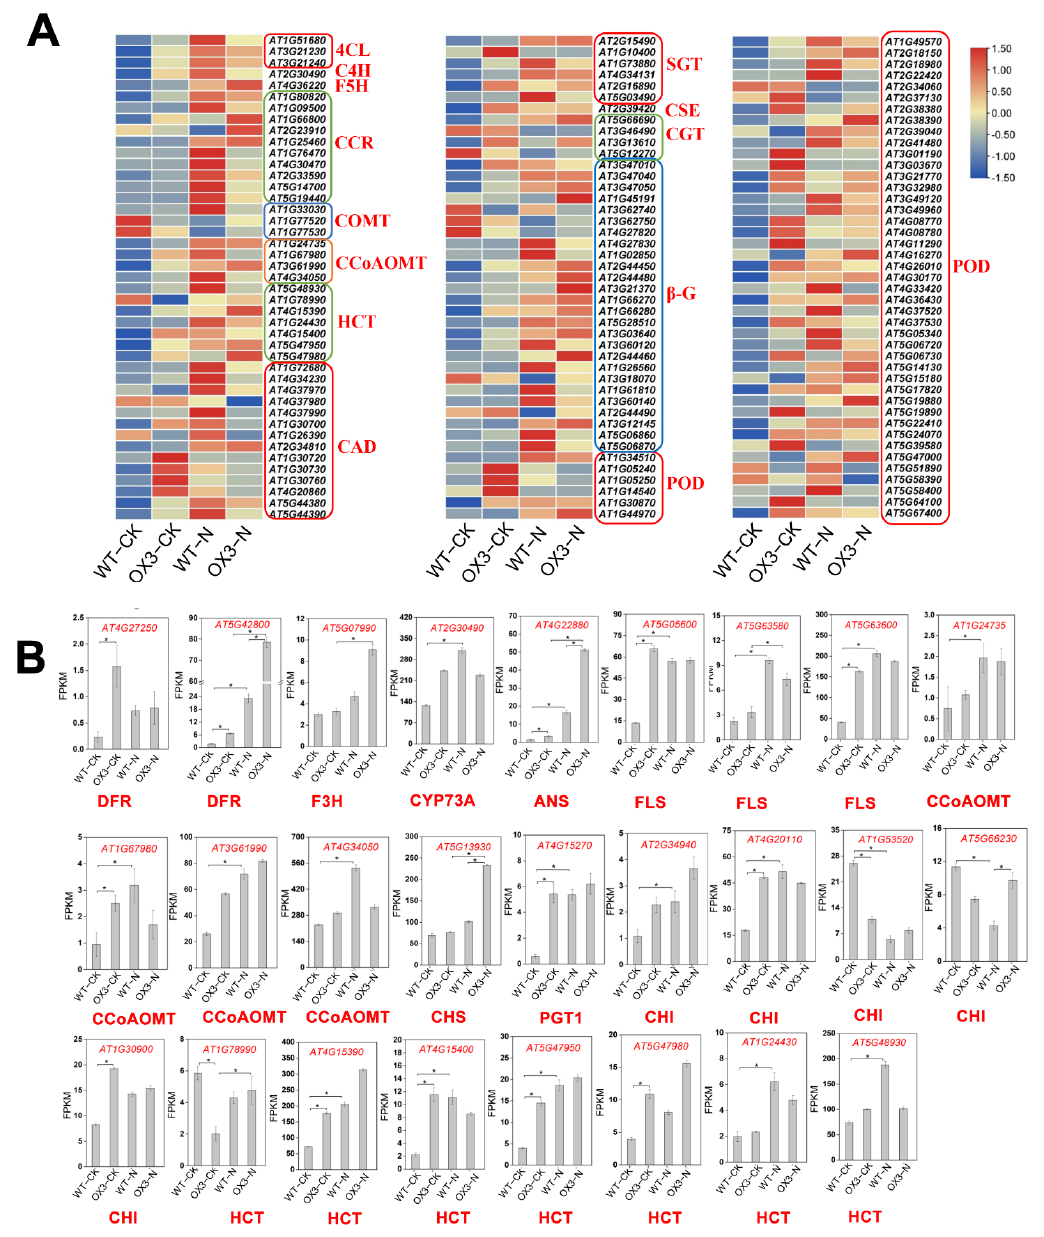
Figure 7. Transcript abundance changes of the phenylpropanoid and flavonoid biosynthesis pathway-related DEGs in Arabidopsis wild type (WT) and transgenic plant (OX3) under NaCl treatment. ( A ) Heat map of DEGs in phenylpropanoid biosynthesis pathway. The log2-transformed FPKM values of DEGs were used to generate the diagram. 4CL, 4-coumarate-CoA ligase; C4H, cinnamate-4-hydroxylase; F5H, ferulate-5-hydroxylase; CCR, cinnamoyl-CoA reductase; CCoAOMT, caffeoyl- CoA O-methyltransferase; COMT, caffeic acid 3-O-methyltransferase; HCT, hydroxyl cinnamoyl transferase; CAD, cinnamyl-alcohol dehydrogenase; SGT, scopoletin glucosyltransferase; CSE, caf- feoylshikimate esterase; CGT, coniferyl-alcohol glucosyltransferase; β -G, beta-glucosidase; POD, peroxidase. ( B ) Gene expression of DEGs in flavonoid biosynthesis pathway. DFR: dihydroflavonol 4-reductase; F3H: flavanone 3-hydroxylase; CYP73A: trans-cinnamate 4-monooxygenase; ANS: an- thocyanidin synthase; FLS: flavonol synthase; CHS: chalcone synthase; PGT1: phlorizin synthase; CHI: chalcone isomerase; HCT: shikimate O-hydroxycinnamoyltransferase. * indicate statistical significance based on two-tailed Student’s t -test at p -values <